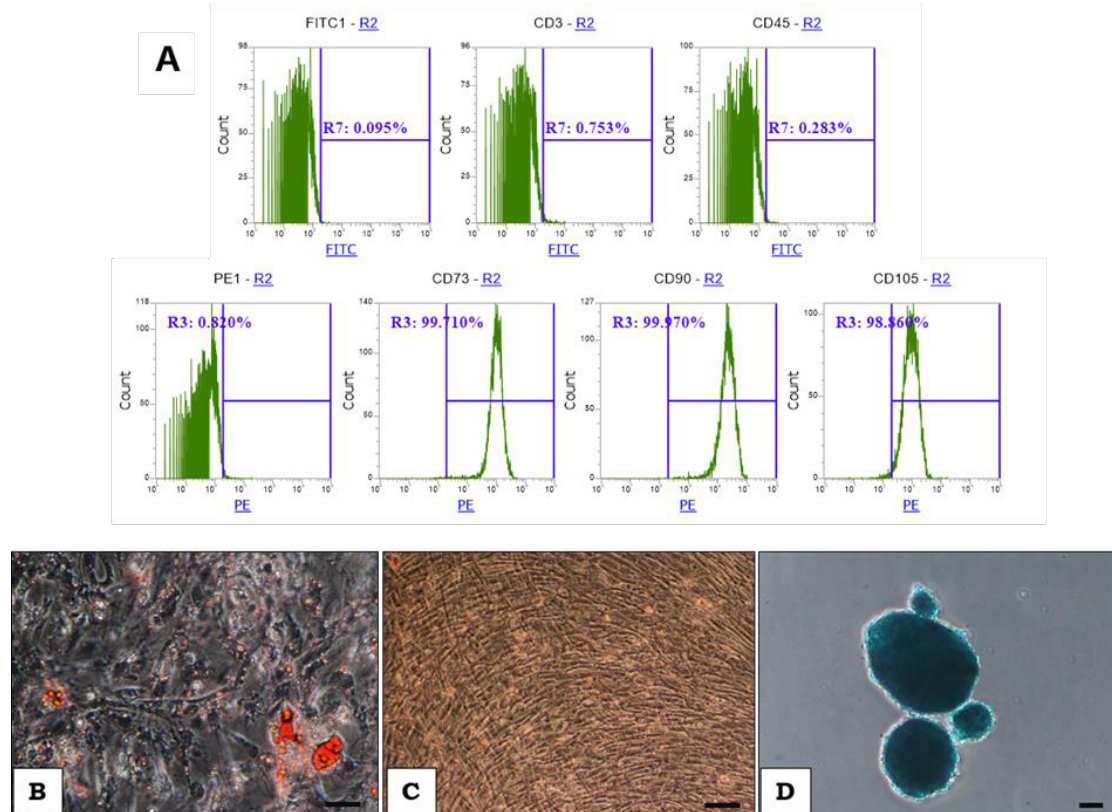
Figure 2. ( A ): The expression levels of surface markers on WJ-MSCs determined by flow cytometry. The WJ-MSCs are characterized by a high expression of CD73, CD90, CD105 (~90%) and a lack of expression of CD3 and CD45. ( B , C , D ): The trilineage potential of WJ-MSCs. WJ-MSCs were able to differentiate into adipocytes (B), osteoblasts ( C ) and chondrocyte ( D ). ( B ): intracellular lipid vacuoles visible in adipocytes after Oil Red staining; ( C ): osteoblasts (Alizarin Red staining); ( D ) chondrocytes (Alcian Blue staining); Light microscopy, magnification × 100, Scalebar = 100 µm.